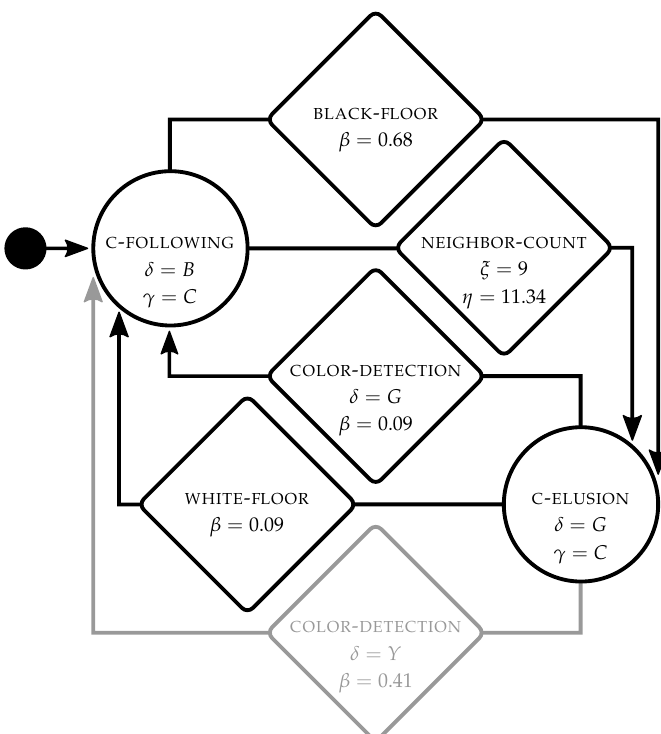
Figure 6. Instance of control software produced by TuttiFrutti for FORAGING . The probabilistic finite state machine shows the effective modules in black and non-reachable modules in light gray. Circular modules represent the low-level behaviors and rhomboid modules represent the transition conditions. Modules labeled as C - FOLLOWING and C - ELUSION stand for the low-level behaviors COLOR - FOLLOWING and COLOR - ELUSION ,